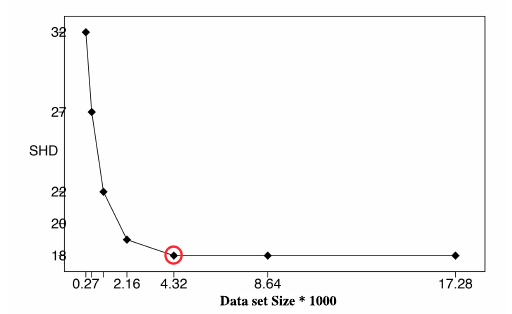
Figure 8. Structural Hamming distance (SHD) of different data set sizes using calculated ALS (Table 3) as reference value (red circle), Insurance Dataset.